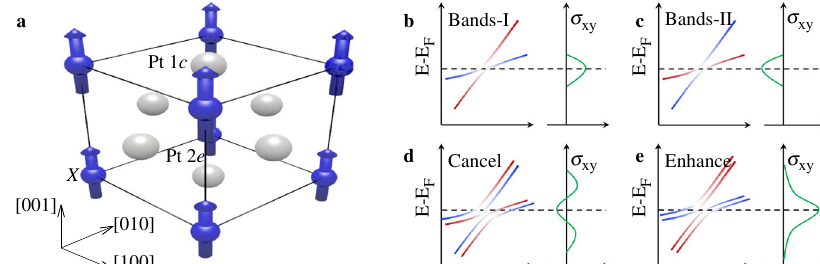
Fig. 1 Crystal and schematic band structure. The crystal structure of X Pt 3 . X is the transition metal (V, Cr, Mn) in blue, Pt 1 c and 2 e in gray are the Wyckoff positions of the Pt atom. b and c Schematic of a single set of band interactions, where E is the band energy and E F the Fermi energy. A change in chirality or magnetization would cause a change in the anomalous Hall conductivity. d and e Schematic of multiple sets of band interactions, where E is the band energy and E F the Fermi